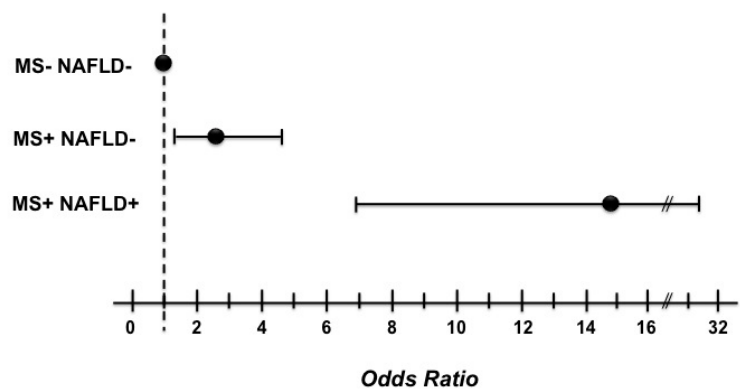
Figure 2. Graphic report of the logistic regression analysis for decreased forearm blood flow.